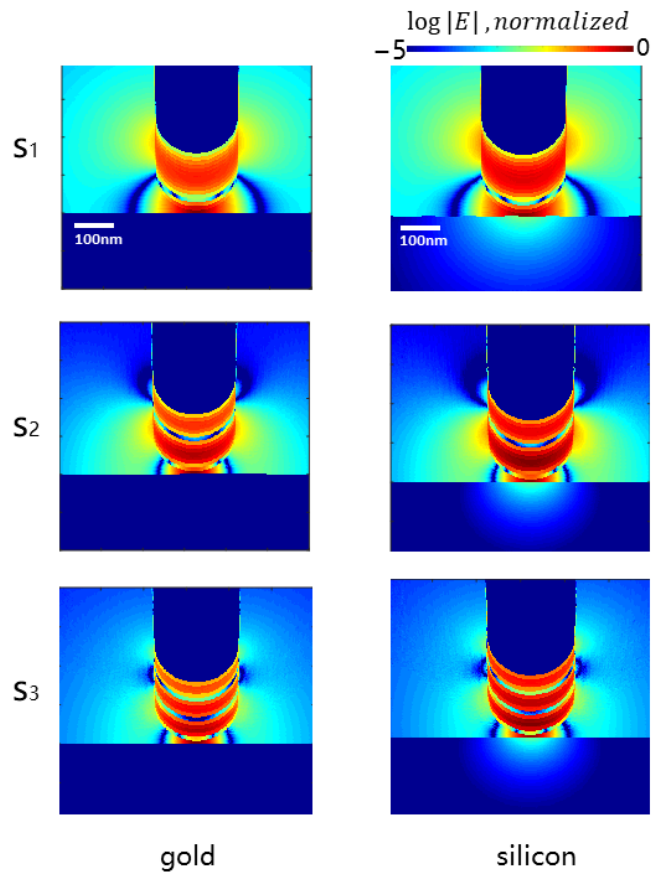
Figure 4. The near-field electric field distribution image for gold and silicon at harmonic order signal (S 1 , S 2 , S 3 ).